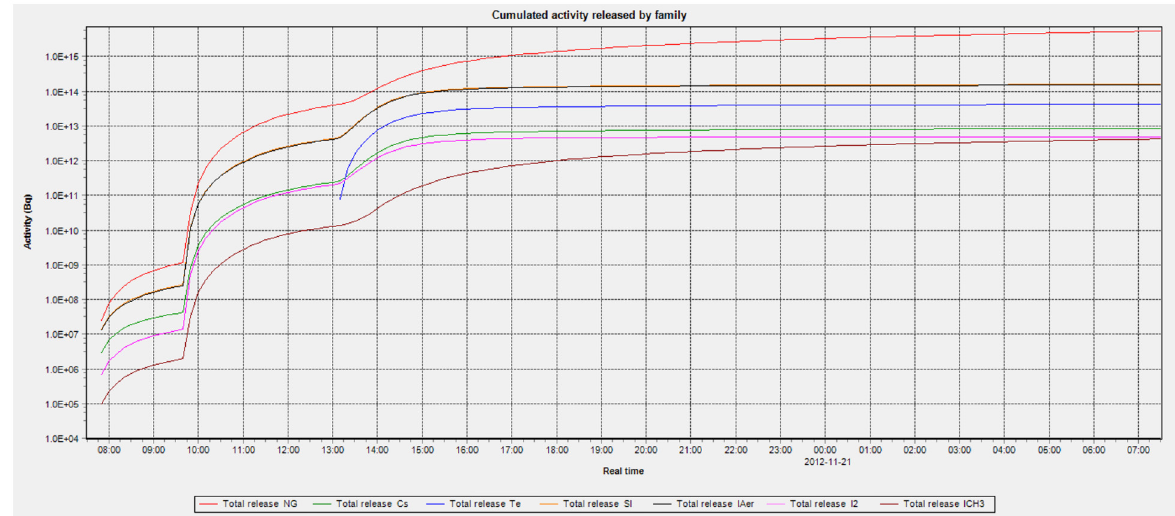
Fig. 3. Example of time-dependent ST obtained with